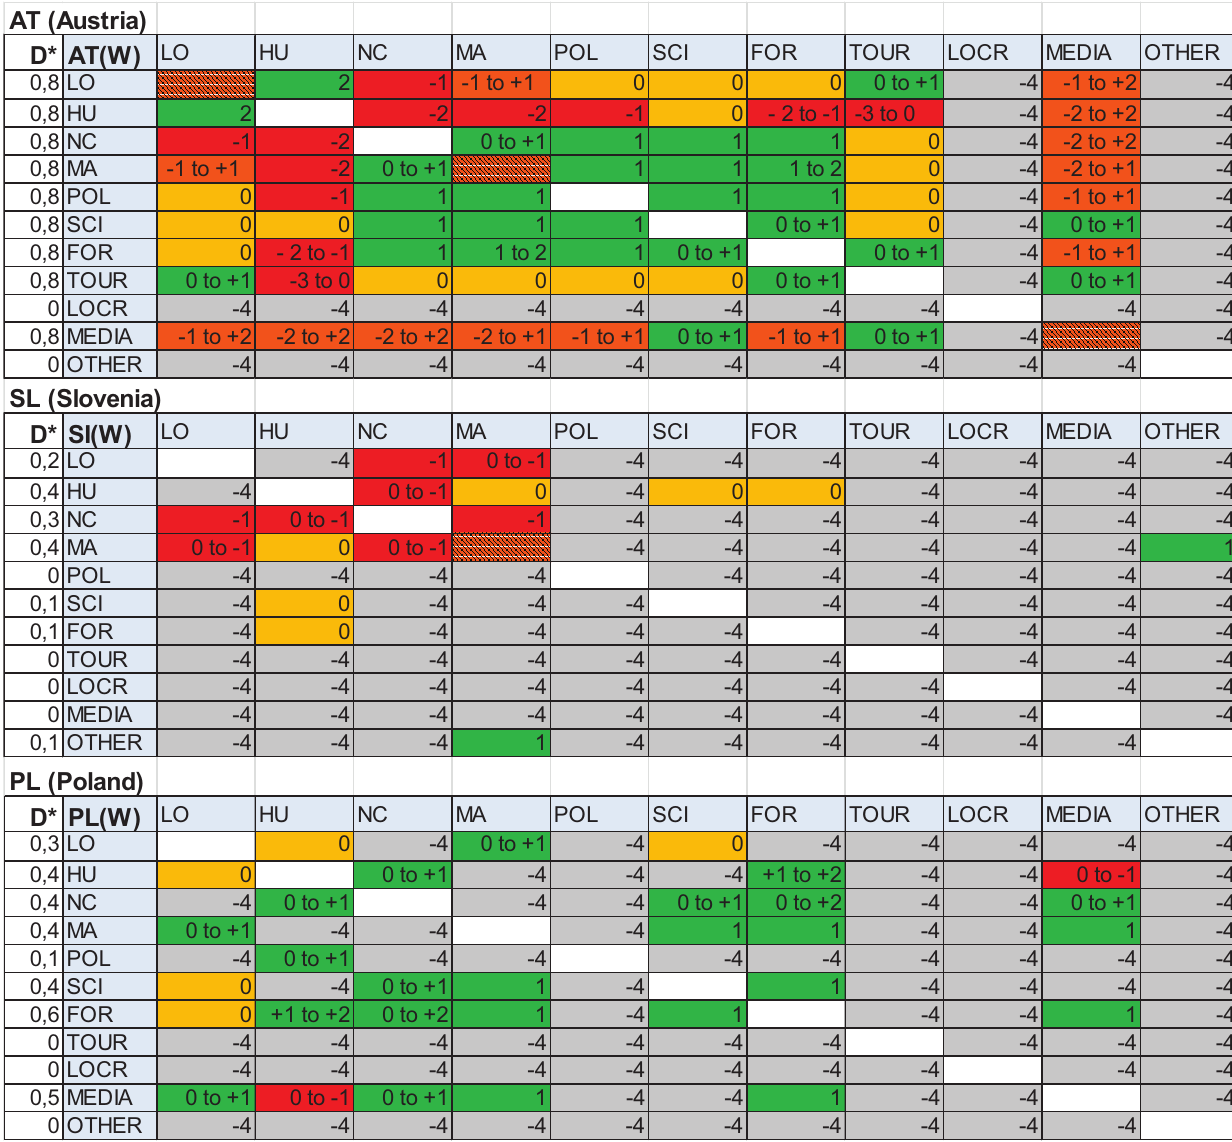
TABLE 7 | Standardized socio-matrices for Austria, Slovenia and Poland categorized for Wolf - 10 Main Stakeholder Categories. AT (Austria) D* AT(W)